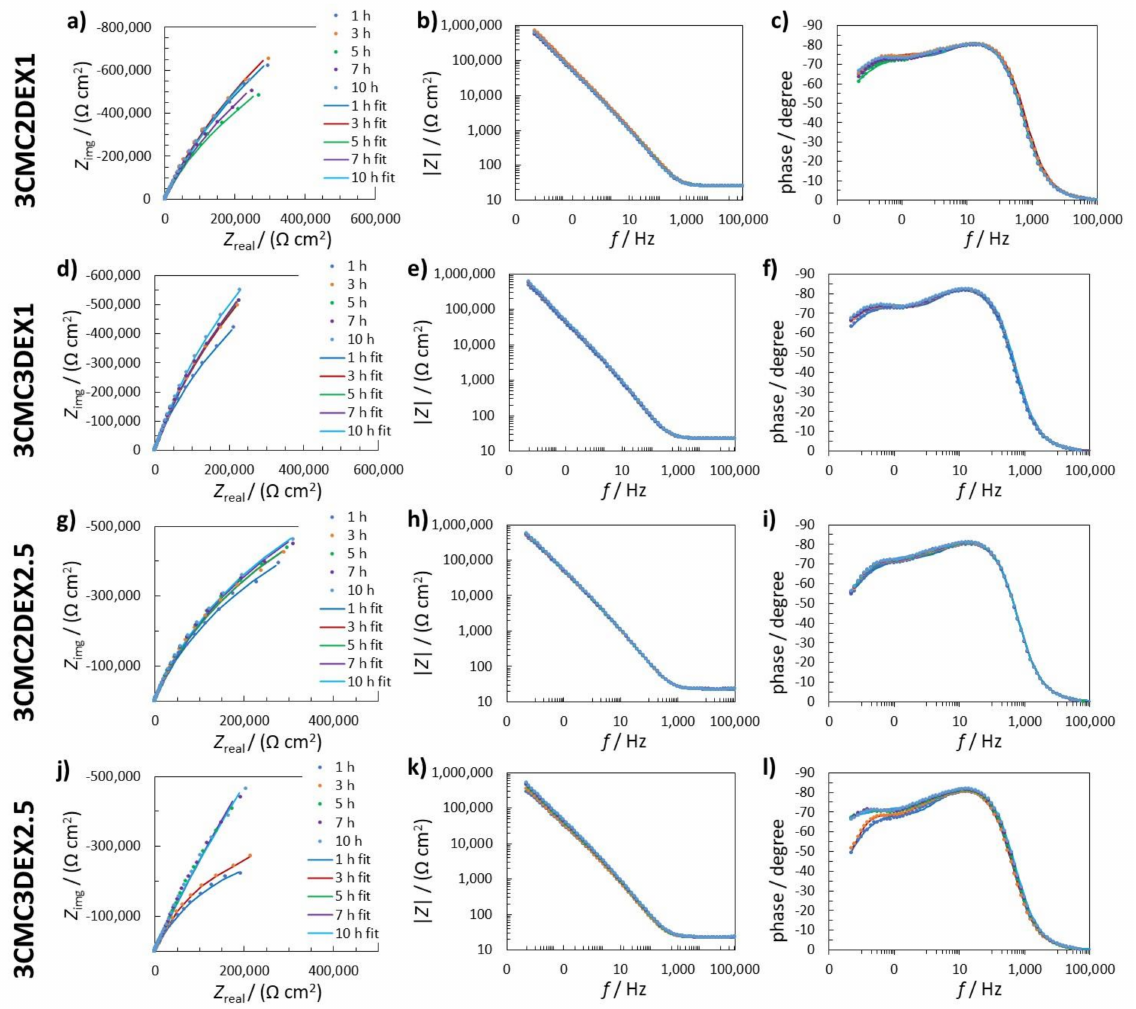
Figure 5. ( a , d , g , j ) Nyquist impedance; ( b , e , h , k ) Bode impedance; and ( c , f , i , l ) phase angle EIS spectra measured in 0.9 wt.% NaCl solution for ( a – c ) 3CMC2DEX1; ( d – f ) 3CMC3DEX1; ( g – i ) 3CMC3DEX1; and ( j – l ) 3CMC3DEX1 samples. The measured data are represented with dots, whereas fitted data are given as solid